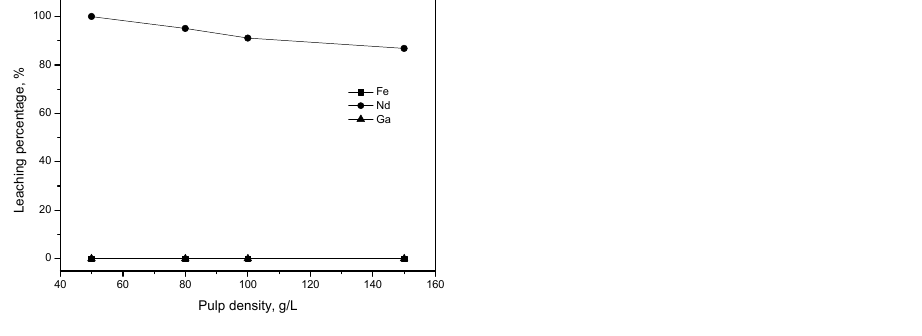
Figure 8. Effect of pulp density on the leaching of oxide mixtures by 0.05 M H 2 SO 4 in EG. Operation conditions: T = 25 °C, time = 60 min, stirring speed = 400 rpm.